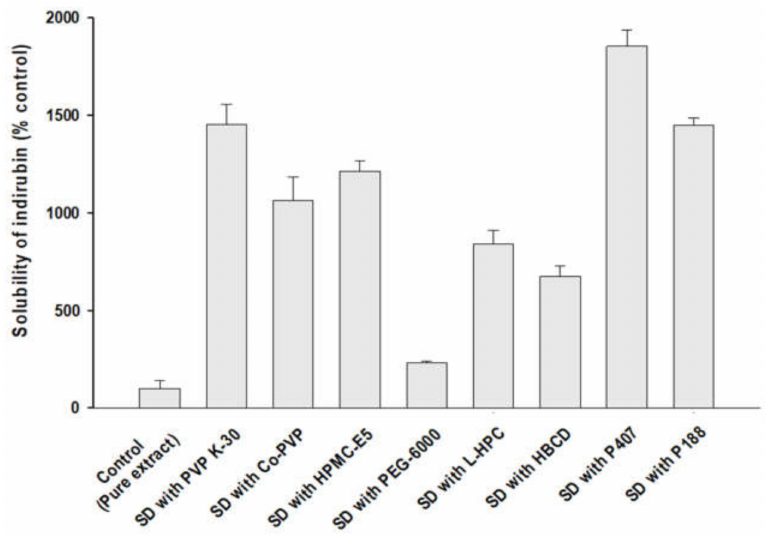
Figure 2. Effect of carriers on the aqueous solubility of indirubin in SD formulations of MT-102 (mean ± s.d., n = 3).